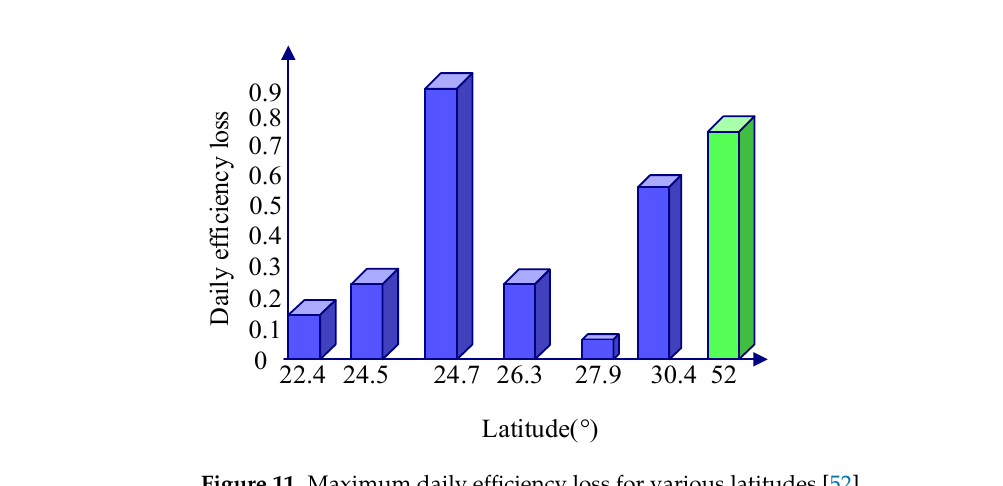
Table 1. The potential electricity generation capacity of BIPV for selected countries of the International Energy Agency [63].